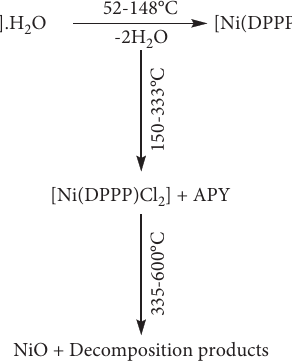
Scheme 1: The decomposition stages for nickel(II) complex in dynamic